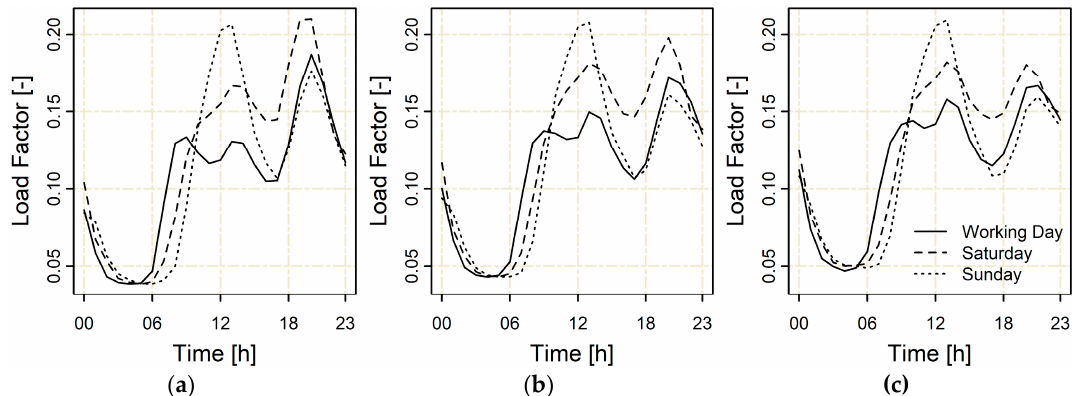
Figure A1. The load factors for three different daily profiles and the seasons ( a ) winter, ( b ) spring, and ( c ) summer represent the hourly percentage of the annual consumption in 1.000kWh/a of a residential building (Source: [32,33] ).